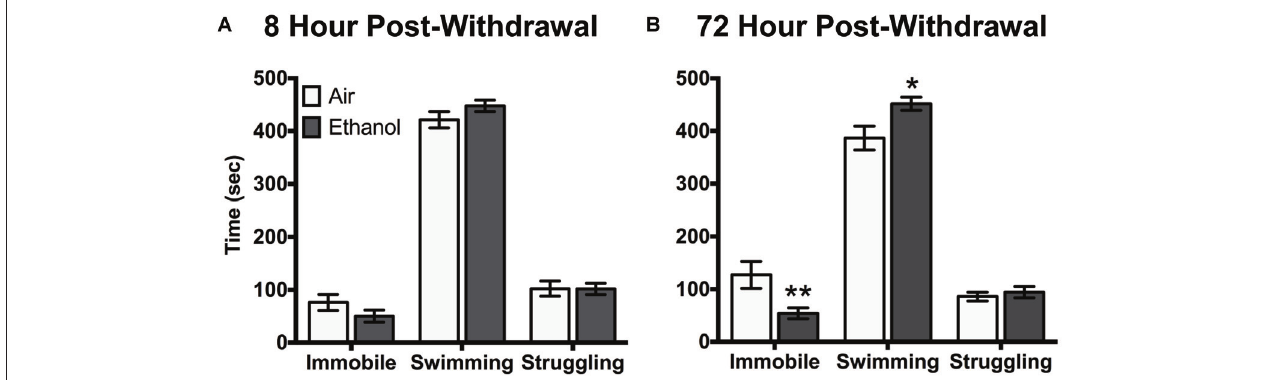
FIGURE 2 | Behavioral response to forced swim stress (FSS) following (A) 8 h or (B) 72 h withdrawal in air-exposed (clear bars) or ethanol-exposed mice (gray bars) . Data are depicted as mean time engaged in each behavior ± SEM. ∗ p < 0.05 compared to respective Air-Stress group. ∗∗ p < 0.005 compared to respective Air-Stress group.